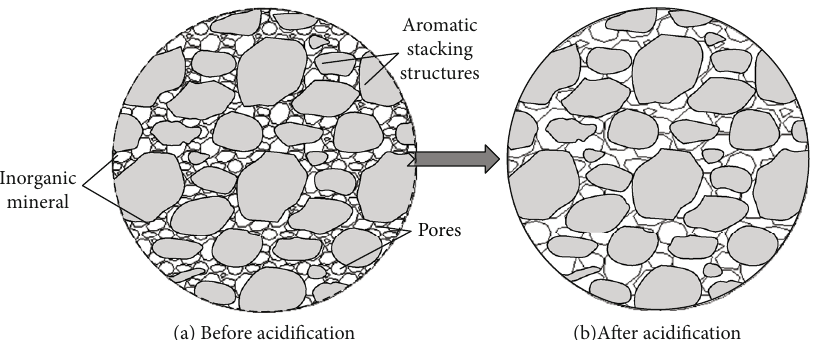
Figure 17: Evolution of pore in coal before and after acidi fi